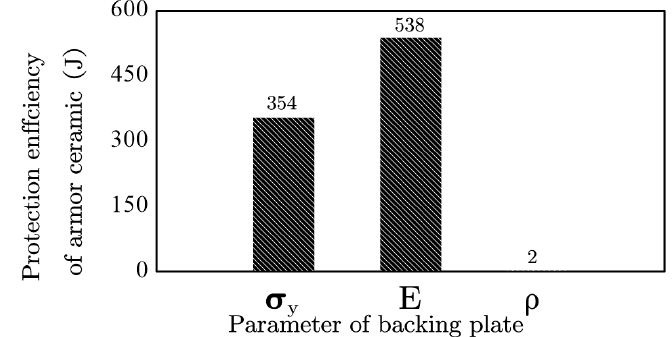
Figure 5. Change in the protection efficiency of the armor ceramic following the backing plate parameter changes.